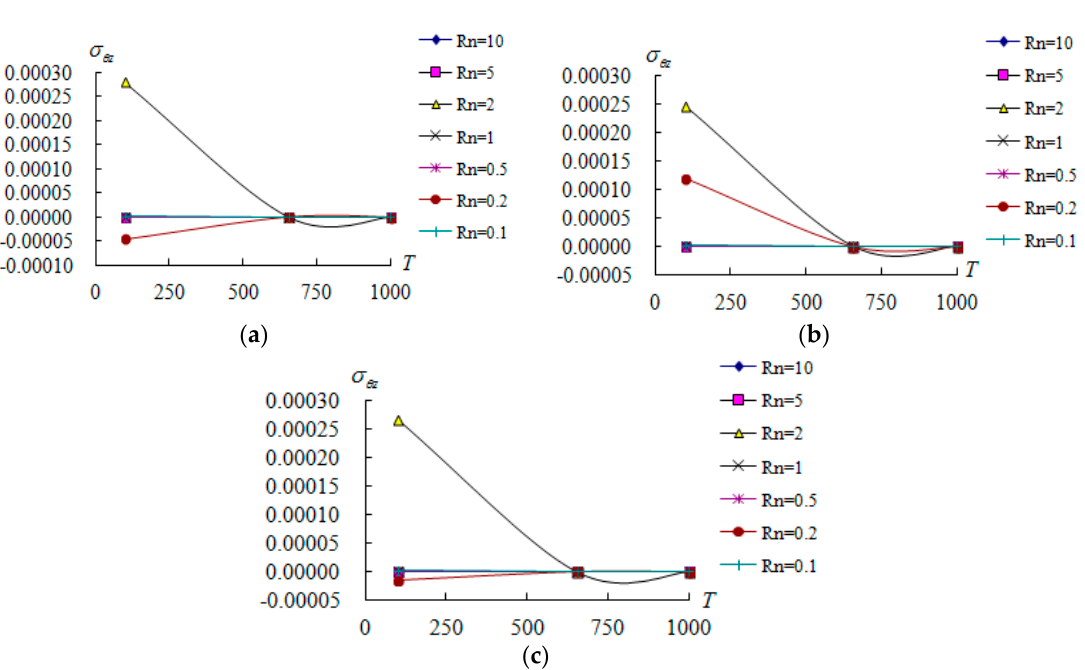
σ Figure 7. (GP a ) versus T ( K ) and for 2 = ∞ M Figure 7. σ θ z (GP a ) versus T (K) and R n for M ∞ = 2, 4, and 10: ( a ) σ θ z (GP a ) versus T (K) and R n for z θ M ∞ = 2; ( b ) σ θ z (GP a ) versus T (K) and R n for M ∞ = 4; and ( c ) σ θ z (GP a ) versus T (K) and R n for for M ∞ = (GP a ) versus T ( K ) and for 10 = ∞ M .